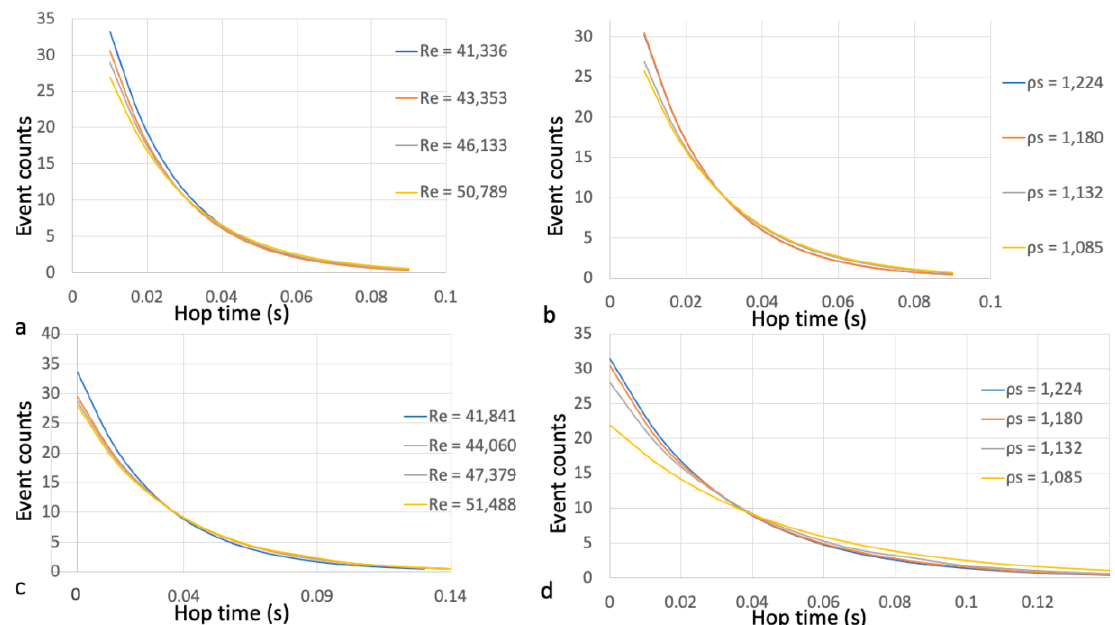
Figure 13. Hop time modelled by the exponential distribution: ( a ) for different flow Reynolds numbers, bed surface A, and fixed instrumented particle density of 1132 kg/m 3 , ( b ) for different instrumented particle densities, bed surface A, and fixed Reynolds number of 50,789, ( c ) for different flow Reynolds numbers, bed surface B, and fixed instrumented particle density of 1132 kg/m 3 , and ( d ) for different instrumented particle densities, bed surface B, and fixed Reynolds number of